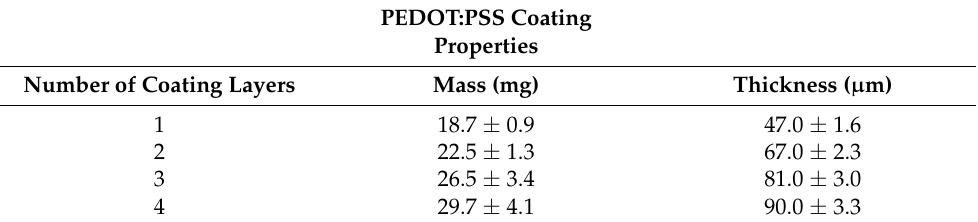
Table 1. Mass and thickness of the PEDOT:PSS coating